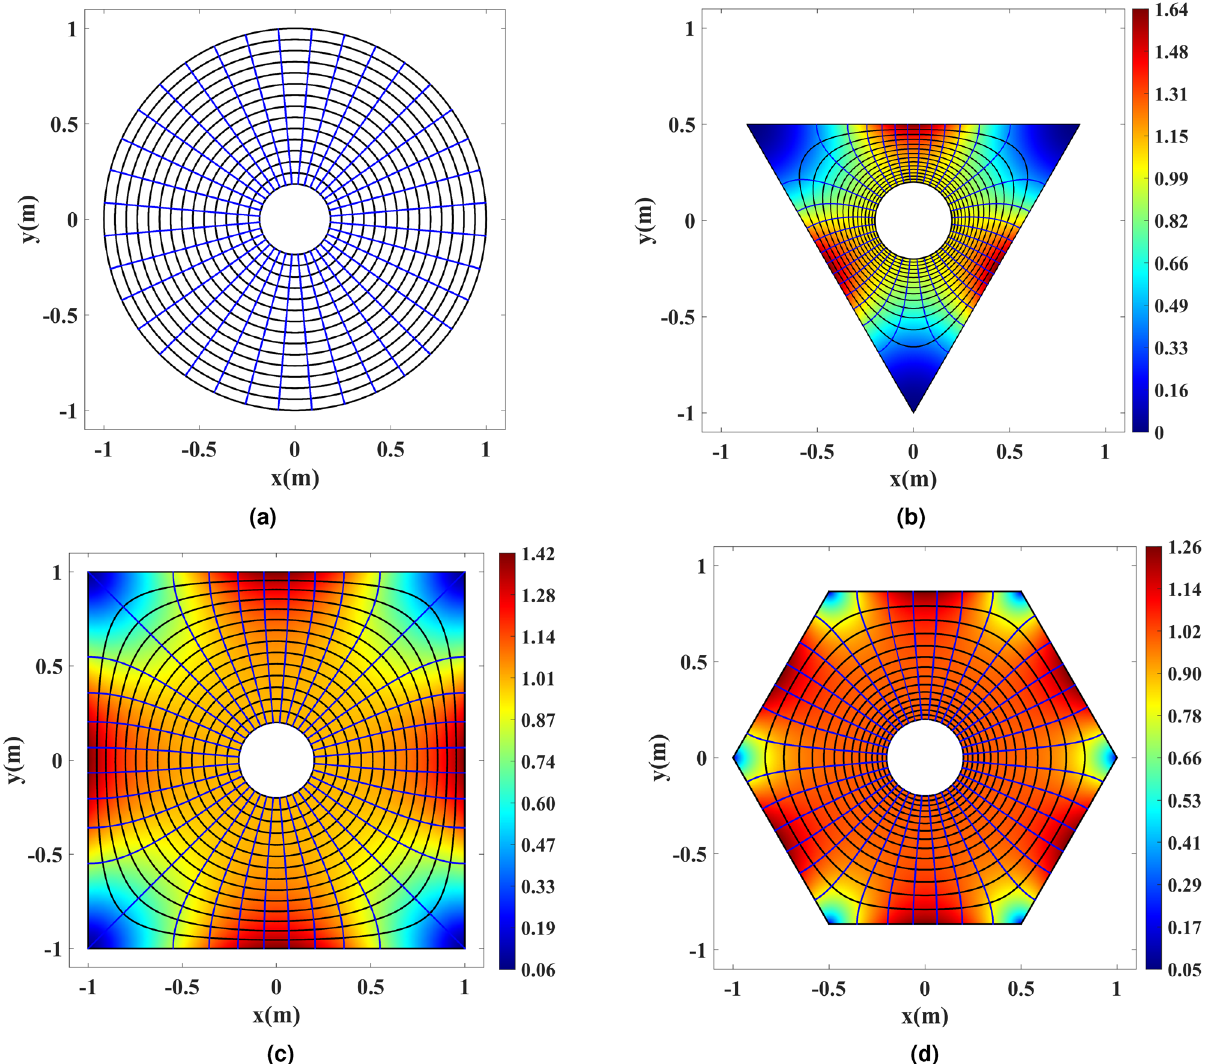
Figure 3. Grid transformation between the virtual and physical spaces. The solid blue lines represent the rays and the solid black lines represent the phase fronts. ( a ) Cylindrical grids in the virtual space annulus. The refractive index and the mapped grids inside ( b ) the triangular, ( c ) the square, and ( d ) the hexagonal physical